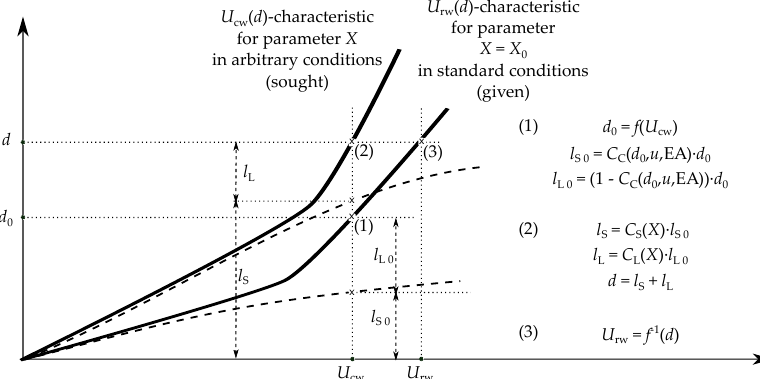
Figure 10. Algorithm of the hypothetical atmospheric correction method in reference to the withstand voltage correction of insulation co-ordination (qualitative